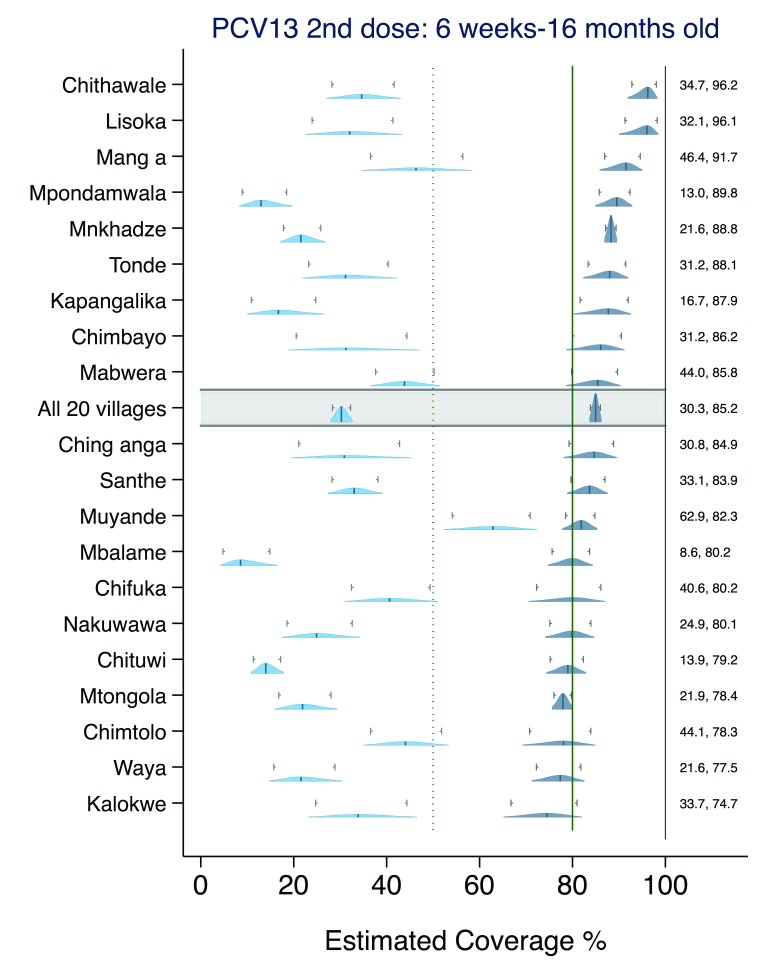
The two-dose coverage of 13-valent pneumococcal conjugate vaccine by lot and survey.Light blue, wave 1 (March 2012); dark blue, wave 6 (June 2014). Numbers on the right indicate the estimated coverage at waves 1 and 6. Tick marks indicate one-sided 95% confidence interval bounds. Green vertical target lines at 50% (dashed) and 80% (solid).